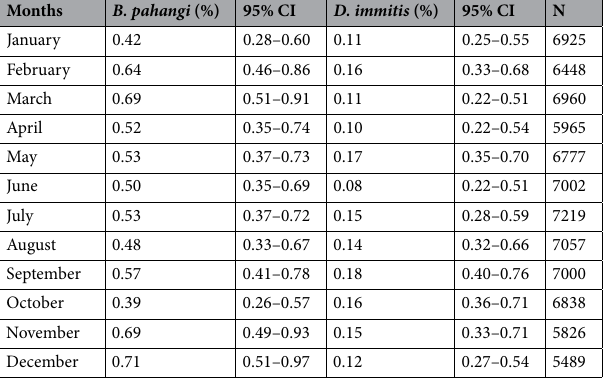
Table 1. Prevalence of B. pahangi and D. immitis positive rate during January–December